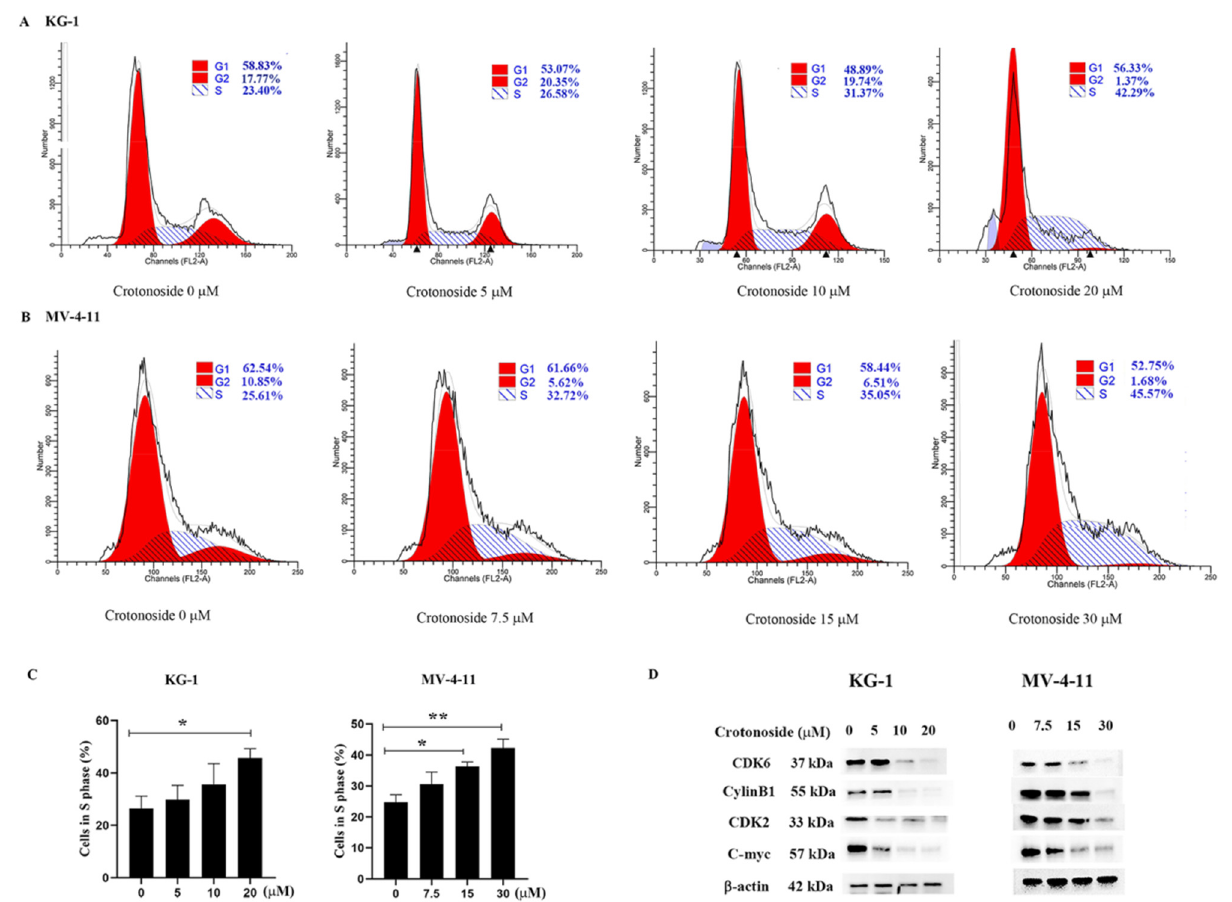
Figure 9. Effect of crotonoside on cell cycle progression of KG-1 and MV4-11 cells: ( A ) KG-1 and ( B ) MV-4-11 cells were treated with different concentrations of crotonoside for 48 h, and 0.1% DMSO (0 μ M) as control, then the cells were harvested and cell cycle was analyzed by flow cytometry; ( C ) Statistical summary of KG-1 and MV-4-11 cells in S phase based on cell cycle analysis, * p < 0.05, ** p < 0.01 vs. 0 μ M. ( D ) Effect of crotonoside on cell cycle-related proteins. After treatment with different concentrations of crotonoside for 48 h, whole-cell lysates were analyzed by Western blot. All the data are presented as means ± SD from three independent experiments.